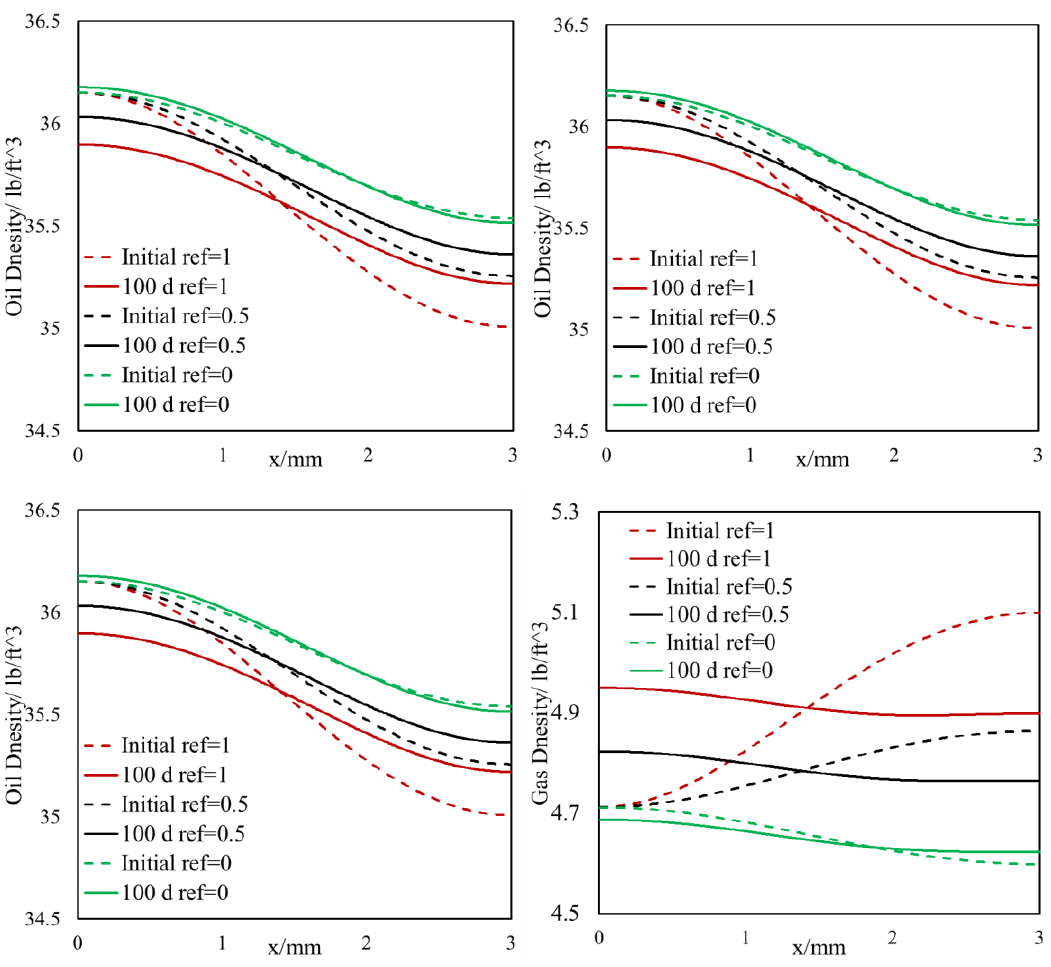
Figure 13. Oil and gas density/viscosity profiles with different reference pressures, with Pc in flow, without diffusion, 100 days, ternary mixture.